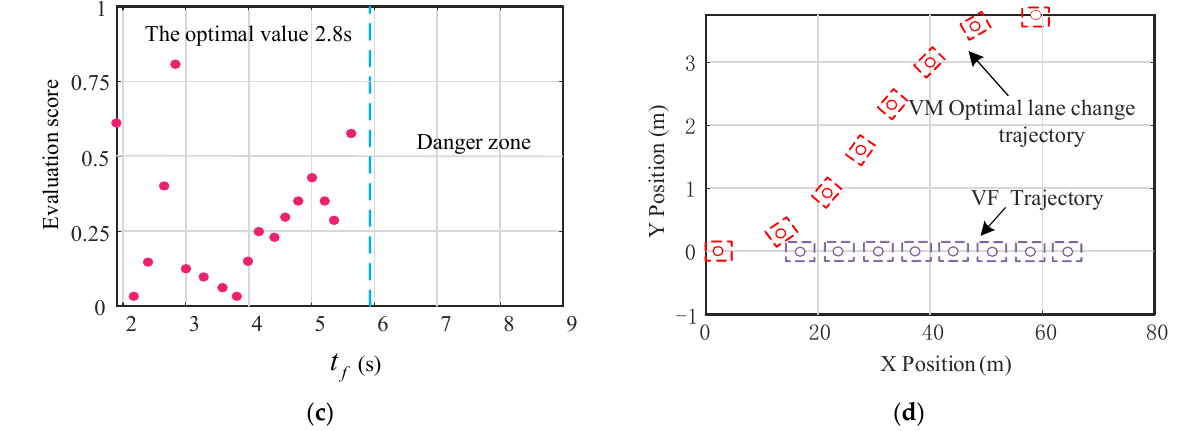
Figure 10. ( a ) Lane change trajectory cluster and lead vehicle trajectory; ( b ) Results of the safe collision avoidance algorithm; ( c ) Results based on Topsis algorithm scores; ( d ) Optimal lane change trajectory for the subject vehicle.